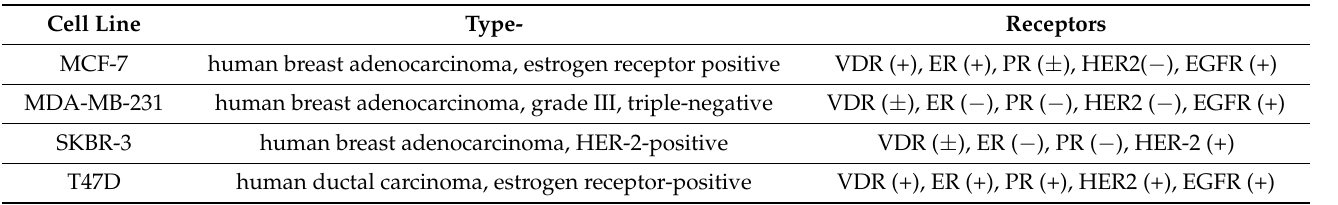
Table 1. The human breast cancer cell lines used in in vitro studies